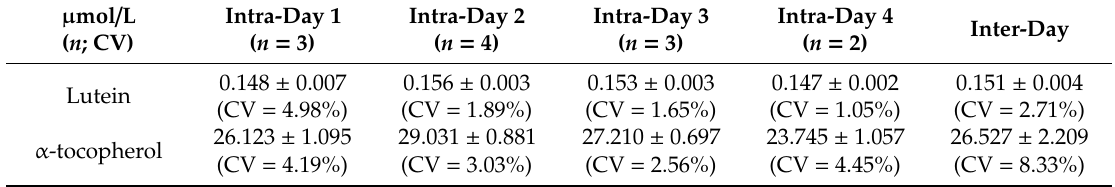
Table A7. Intra-day and inter-day precision of lutein and α -tocopherol in human serum.